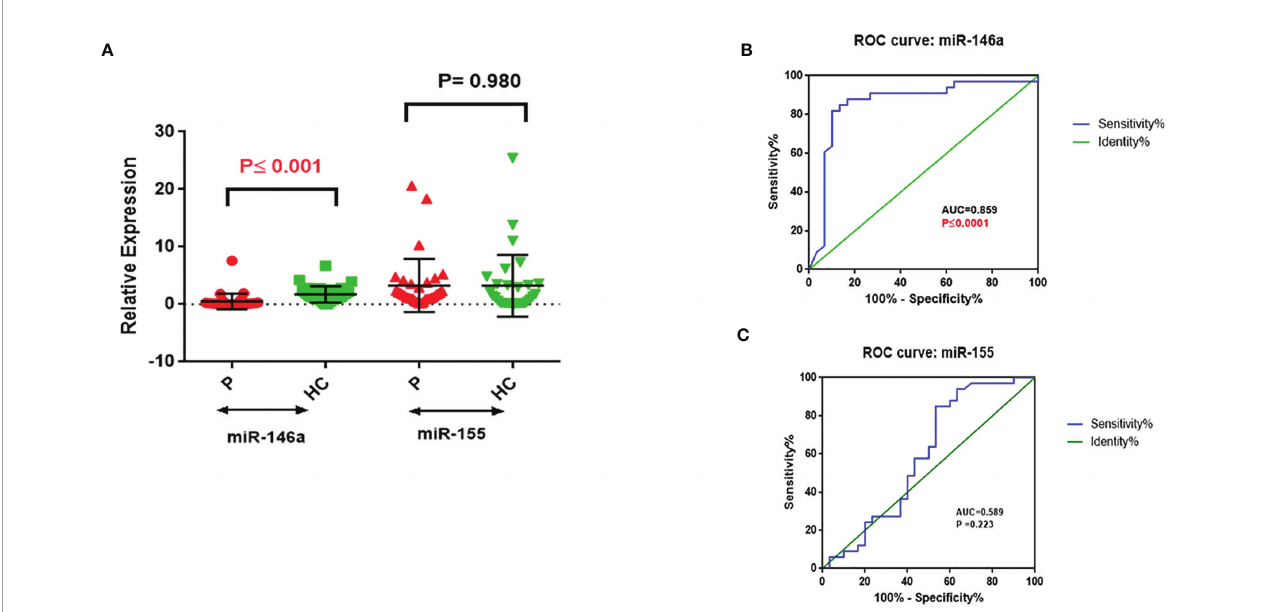
FIGURE 1 | Relative expression of miR-146a and miR-155 in PBMC with ROC correlation in NSCLC and healthy control. (A) miR-146a and miR-155 relative expression; miR-146a signi fi cantly downregulated in NSCLC PBMCs. (B) miR-146a and (C) miR-155 expression level ROC curve; miR-146a identi fi cation of NSCLC patients from healthy